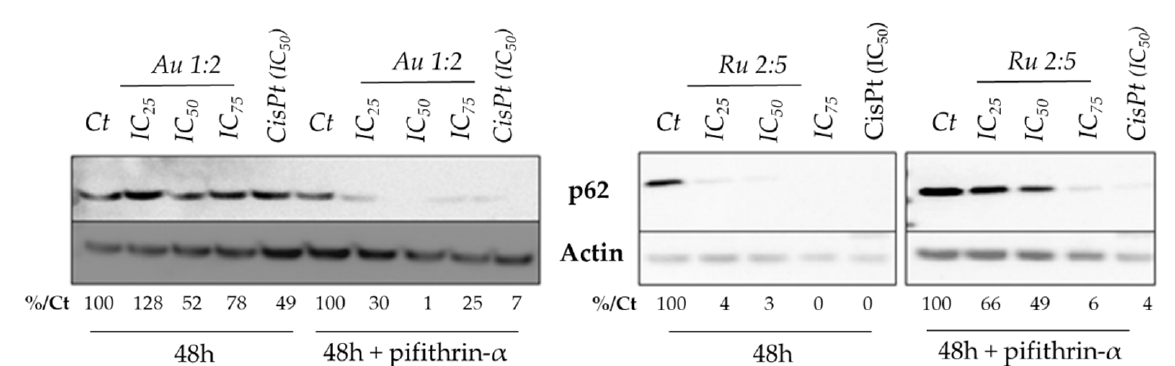
Figure 5. Expression of the autophagy biomarker p62 in HCT116 cells with and without co-treatment with pifithrin- α over 48 h. Cisplatin was used as positive control (IC 50 ). This image is representative of three independent experiments.